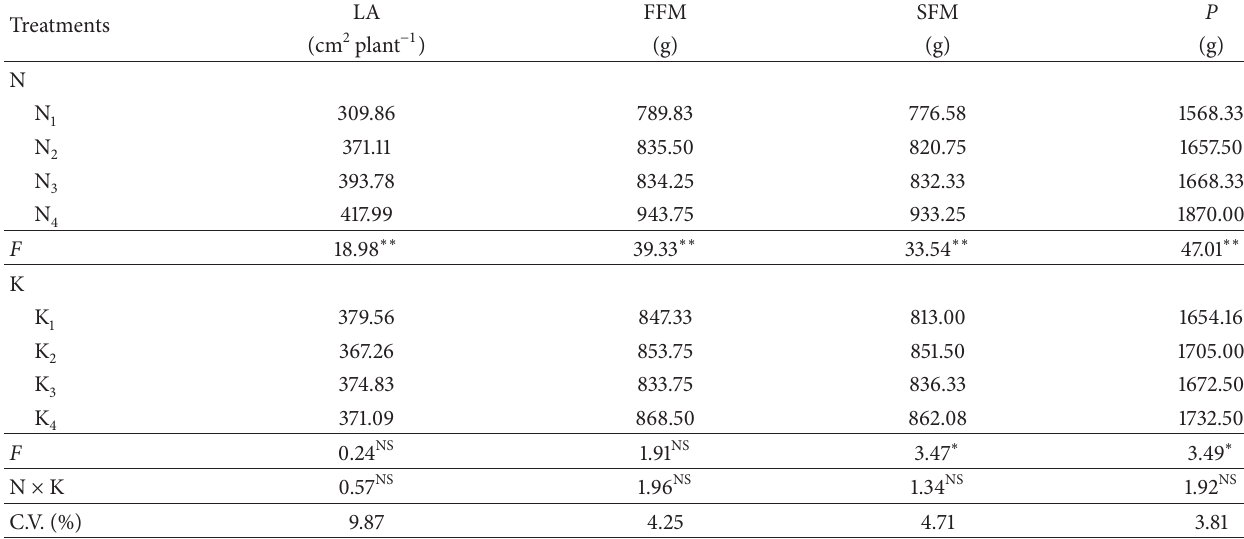
Table 3: Analysis of variance results for leaf area (LA), mass of the first fruit (FFM), mass of the second fruit (SFM), and fruit productivity per plant ( 𝑃 ) as influenced by the concentrations of N and K in the nutrients solution. LA FFM SFM P Treatments (cm 2 plant −1 ) (g) (g) (g) N N 1